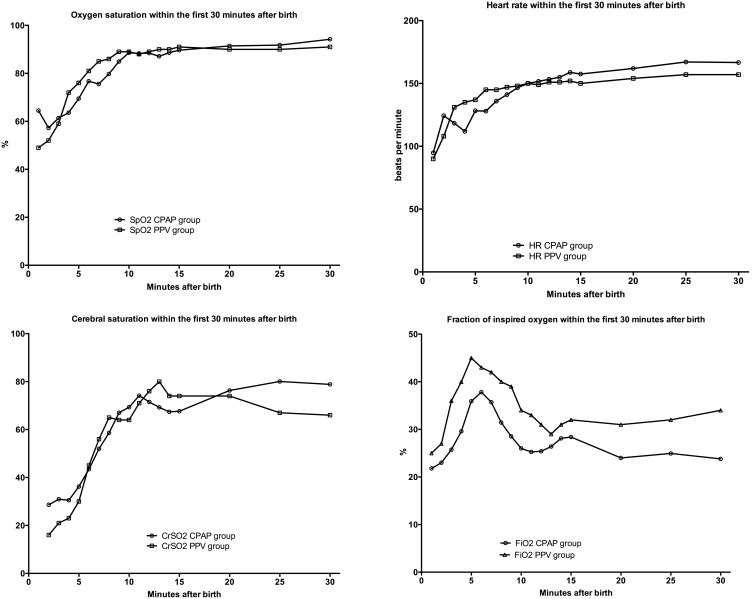
Changes in oxygen saturation (SpO2), heart rate (HR), fraction of inspired oxygen (FiO2) and cerebral oxygenation (rSO2) for infants supported with CPAP or PPV.